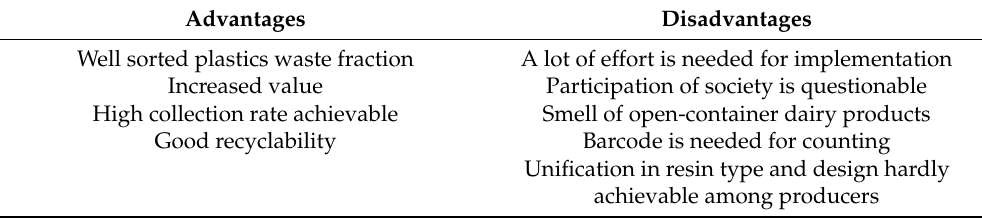
Table 2. Advantages and disadvantages for adding Skyr cups to the deposit